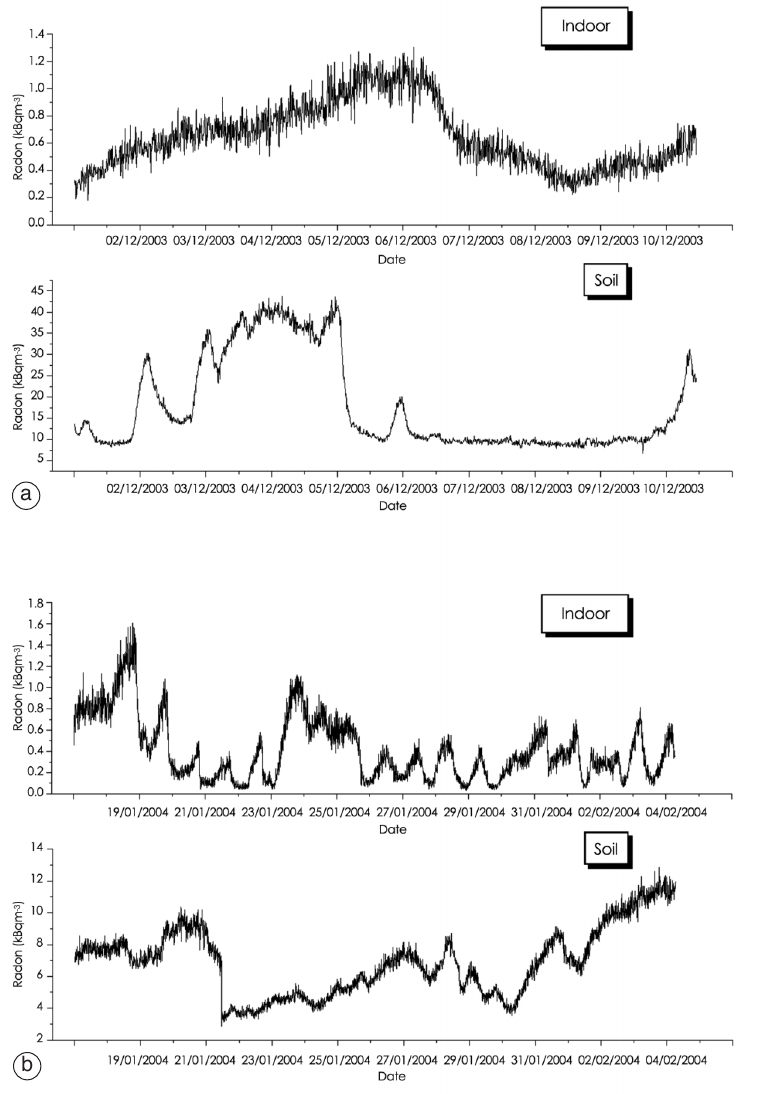
Fig. 2a,b. Radon concentration: a) Modica December 1st, 2003-December 11th, 2003; b) Ragusa January 17th, 2004-February 5th,